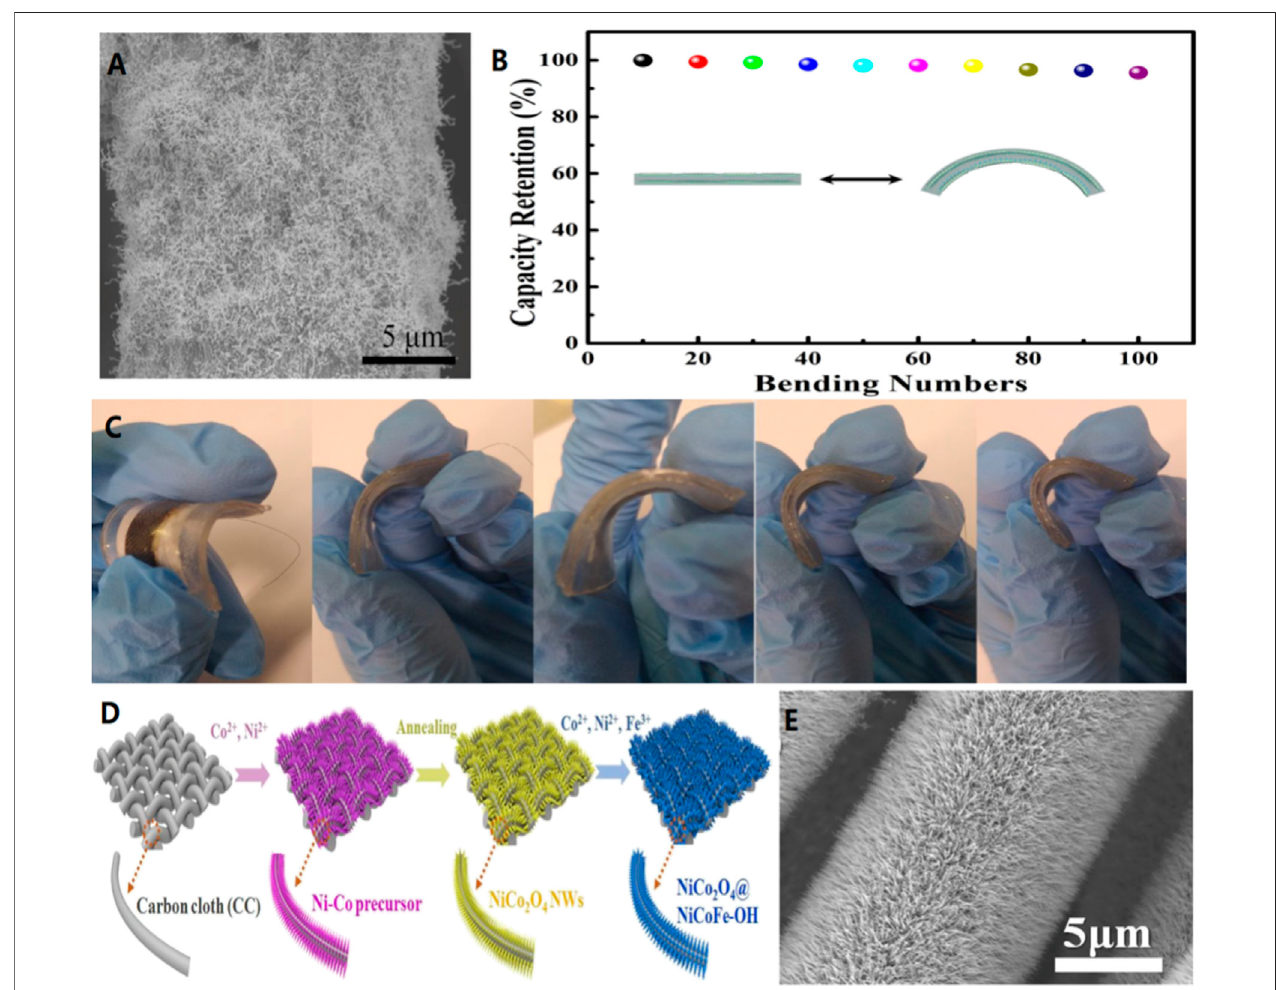
FIGURE8 |(A) SEM ofMOF derivedAg nanowires/CCat Ar/NH 3 . (B) Normalized capacity of thequasi-solid-state Ag-Zn battery bent 135 ° for 100cycles. (C) The photographs of bent quasi-solid-state Ag-Zn battery.Copyright 2018 American Chemical Society. (D) Scheme of the synthetic process of NiCo 2 O 4 @NiCoFe-OH.